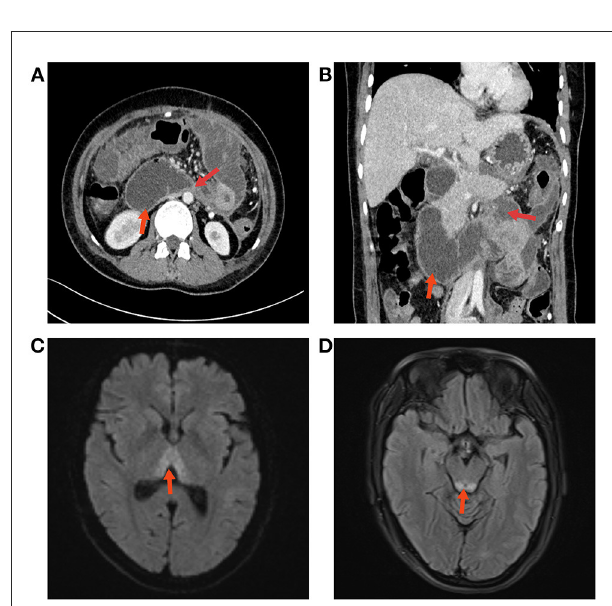
FIGURE2 (A, B) Abdominal CT re-examination showed duodenal obstruction and proximal dilatation. (C) The results of the cranial MRI suggested patchy abnormal signal shadows in the bilateral medial thalamic region. (D) Edema was evident in the dorsal area of the brain